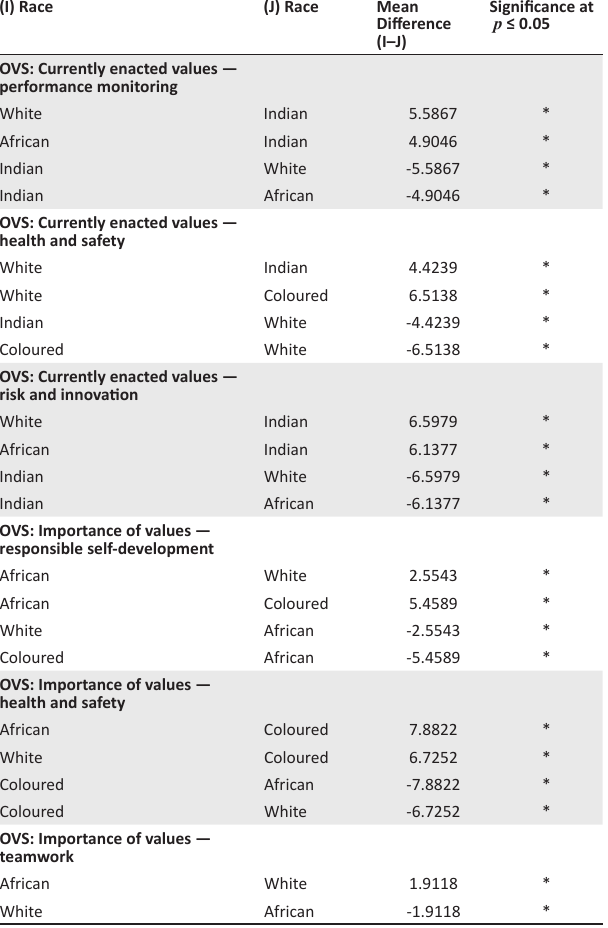
TABLE 4a: Summary of Scheffé Multiple Significant Mean Comparison tests ( n = 988 ): Race. (I) Race (J) Race